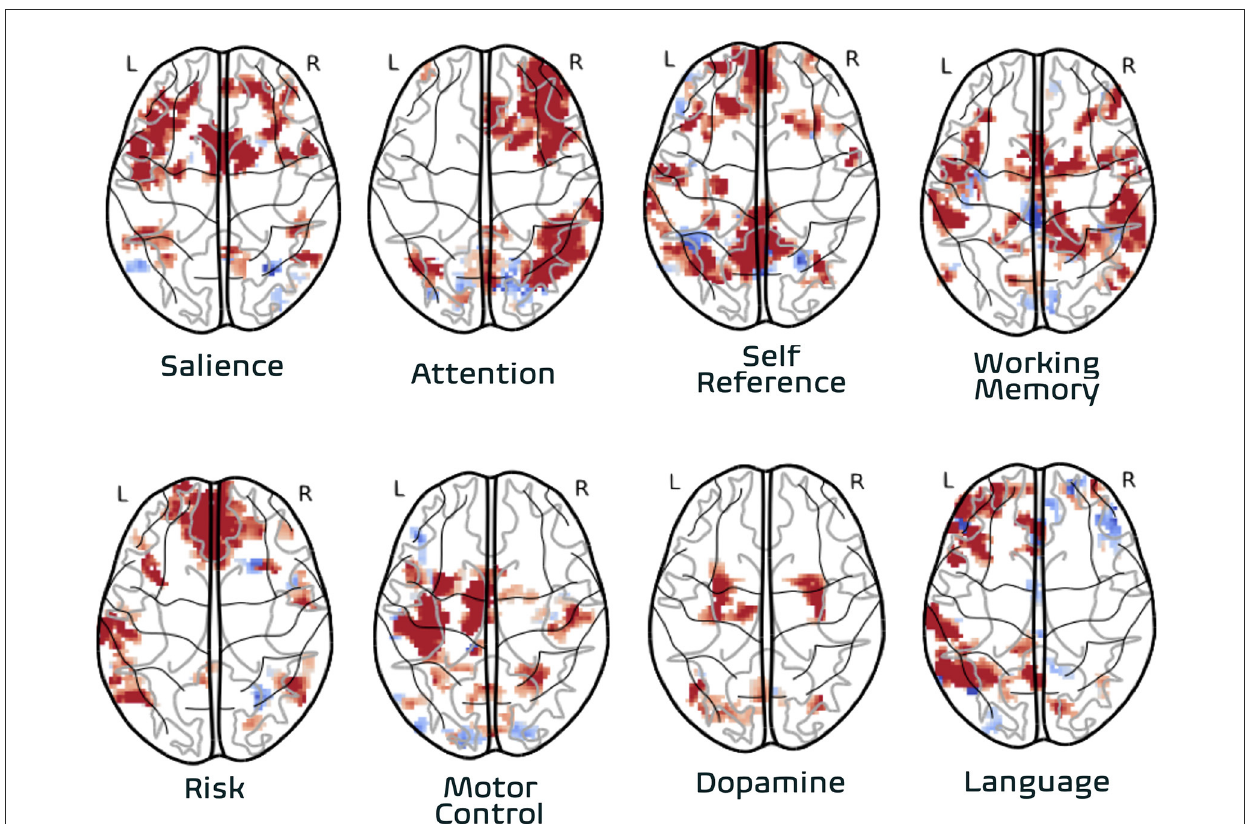
FIGURE1 Association of individual subject functional networks to functional domains. Functional networks from one individual are derived from one resting-state fMRI dataset (8 min. acquisition) acquired with high-reproducibility fMRI strategy ∧ 7,8 (multi-band multi-echo fMRI). The association to functional domains is based on automated lookup in meta-analytic database (image-based query) representing task-activation foci from over 15,000 neuroimaging studies conducted over 30 years (neurosynth.org). Association of individual subject network imaging data to functional domain made via automatically synthesized image representing functional domain using forward-inference model (frequentist)